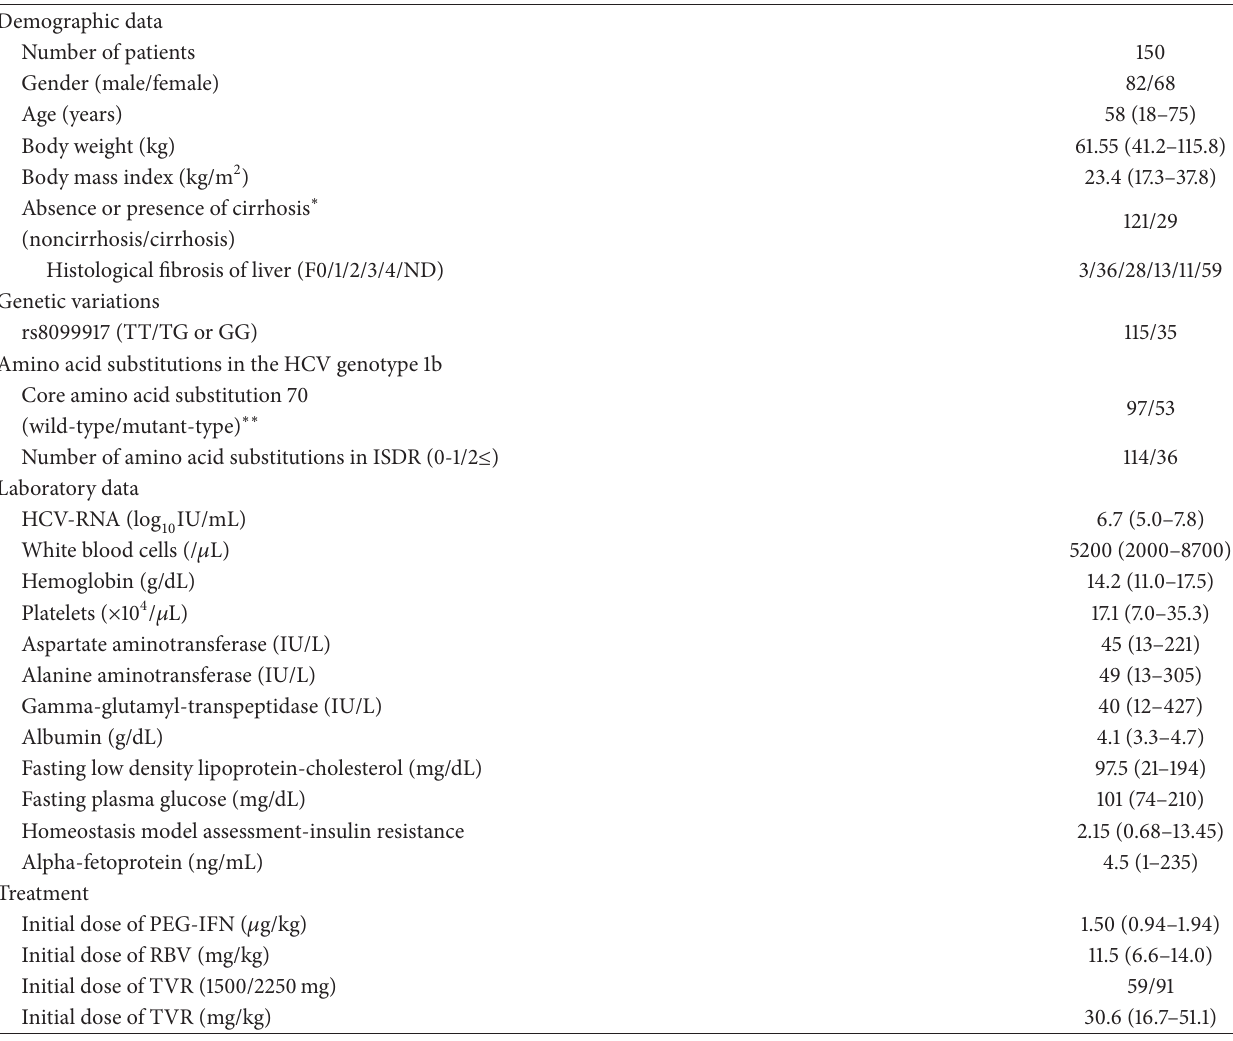
Table 1: Profile and laboratory data at the start of telaprevir-based peginterferon plus ribavirin combination therapy in patients infected with hepatitis C virus genotype